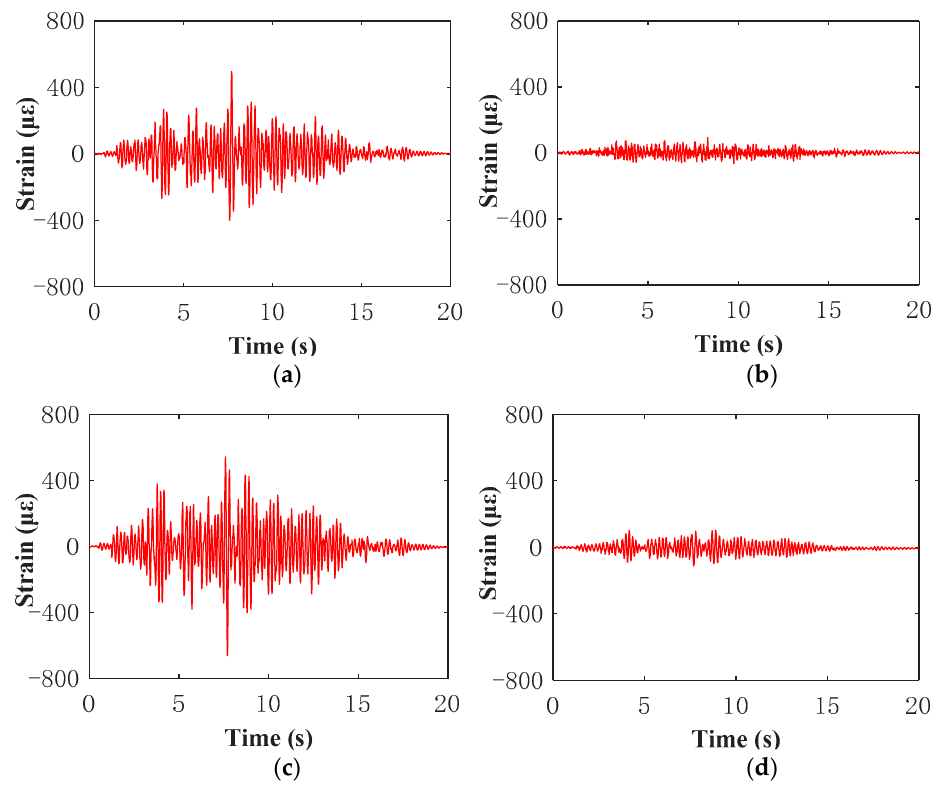
Figure 12. Time series of the strain response on measuring point S1. API (American Petroleum Institute) seismic wave with a peak ground acceleration of 0.25 g. ( a ) Strain at strain gauge no.1, ( b ) strain at strain gauge no.2, ( c ) strain at strain gauge no.3 and ( d ) strain at strain gauge no.4.